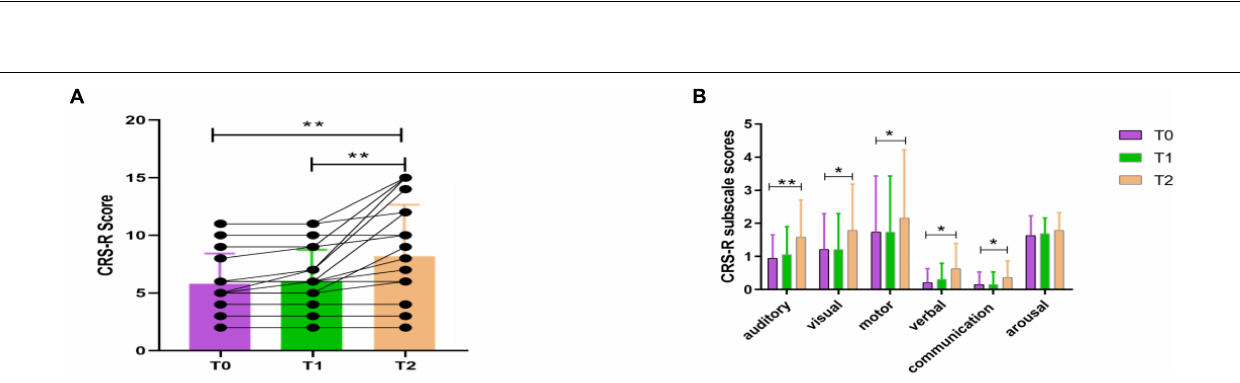
FIGURE 2 | HD-tDCS electrode positions. F3 represents the anodal electrode, and AFz, FCz, F7, and C5 represent cathodal electrodes. Stimulated distribution of the electric field in cortical gray matter with the selected montage.